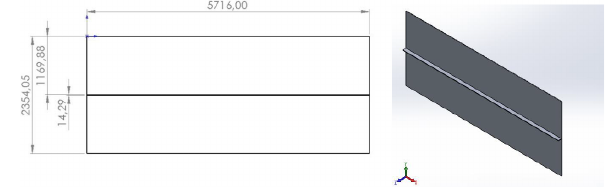
Figure 8: Geometrical model of the flat wall with a single stiffener